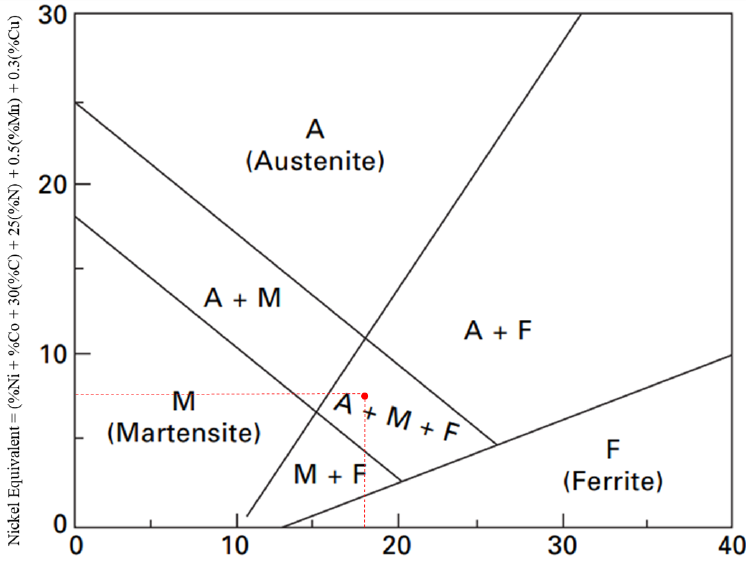
Figure 1. Possible phases of 17-4 PH shown in red dot according to Schaffler Diagram (reproduced with permission from Elsevier, 2022) [15,16].